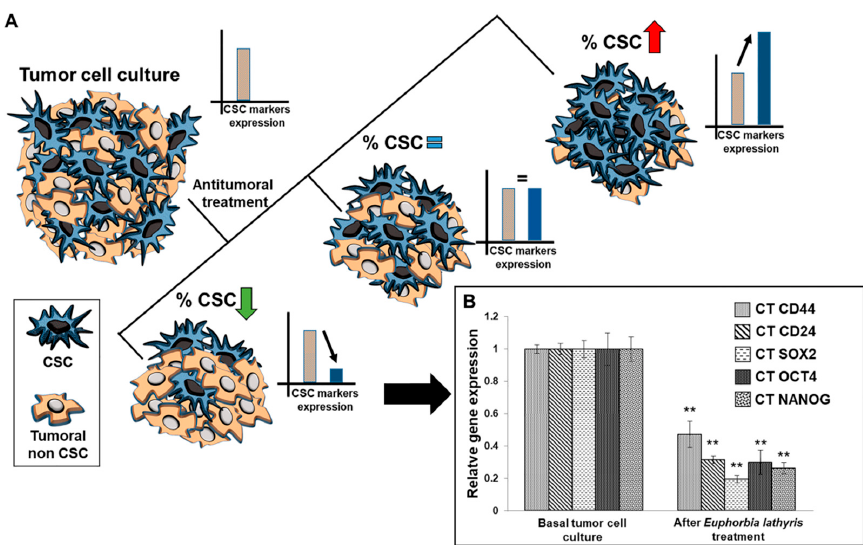
Figure 5. RT-qPCR analysis of cancer stem cell markers. ( A ) Scheme of the possible responses after antitumor treatment in the basal population of tumor cells. The expression levels of cancer stem cell (CSC) markers are related to the percentage of CSC in the tumor culture after antitumor treatment. ( B ) Representative graph showing the relative gene expression of stemness-related markers before (basal) and after exposure to the ethanolic extract from the defatted flour of Euphorbia lathyris . Data are presented as mean ± standard deviation of three independent experiments; * p < 0.05 vs. the respective control group; ** p < 0.01 vs. the respective control group.